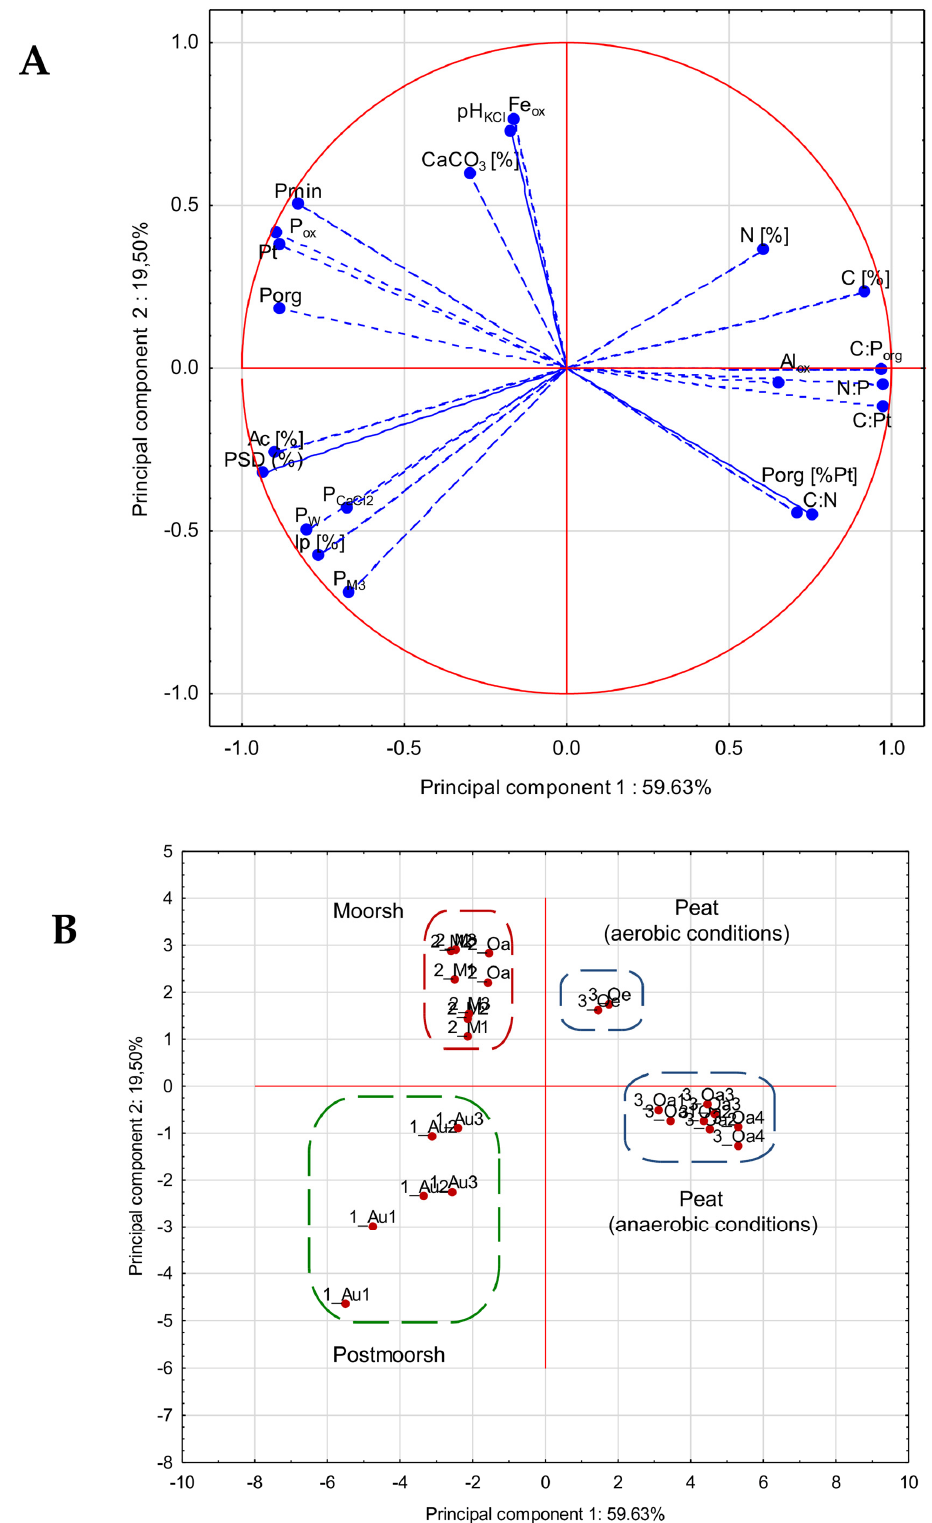
Figure 7. Principal component analysis (PCA) diagram of variables ( A ) and cases ( B ) for organic horizons of soils under